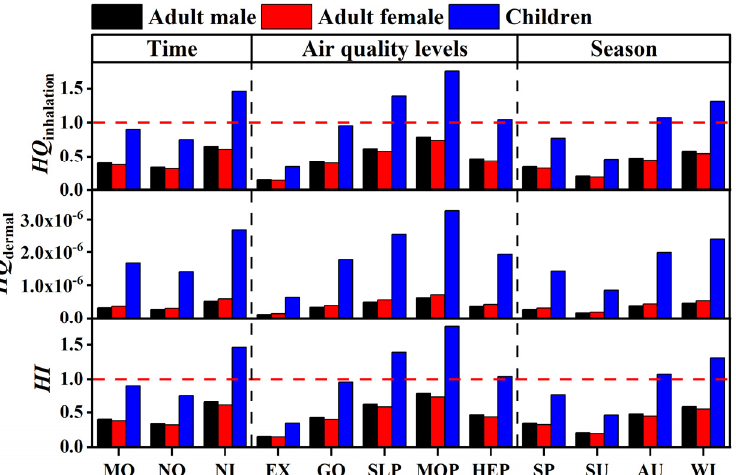
Figure 6. HQ and HI of airborne bacteria under different diurnal periods, air quality levels, and seasons. (MO: morning; NO: noon; NI: night; EX: excellent; GO: good; SLP: slight pollution; MOP: moderate pollution; HEP: heavy pollution; SP: spring; SU: summer; AU: autumn; WI: winter).